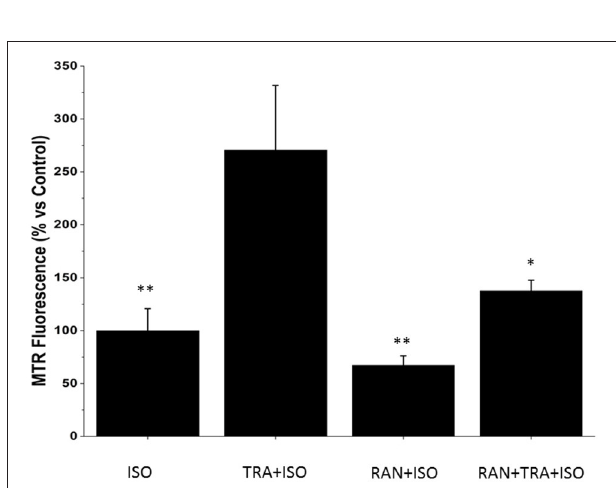
FIGURE 4 | Ranolazine (RAN) reduces Reactive Oxygen Species (ROS) formation induced by Trastuzumab (TRA) and isoproterenol (ISO). Neonatal Rat Ventricular Myocytes (NRVMs) untreated or treated for 24h with 2 µ M TRA, with 10 µ M Ran or with 2 µ M TRA and 10 µ M Ran, were incubated for 1h with 4 µ M Iso. Microscopy analysis of cells labeled with the fluorescent probe Mitotracker Red CM-H2XRos was performed to detect the degree of mitochondrial oxidative stress. Data are normalized to the control after 24h + 1h of treatment with isoproterenol. n ISO: 24; n TRA + ISO: 22; n RAN + ISO: 19; n RAN + TRA + ISO: 20. * p < 0.05 vs. TRA; ** p < 0.01 vs.